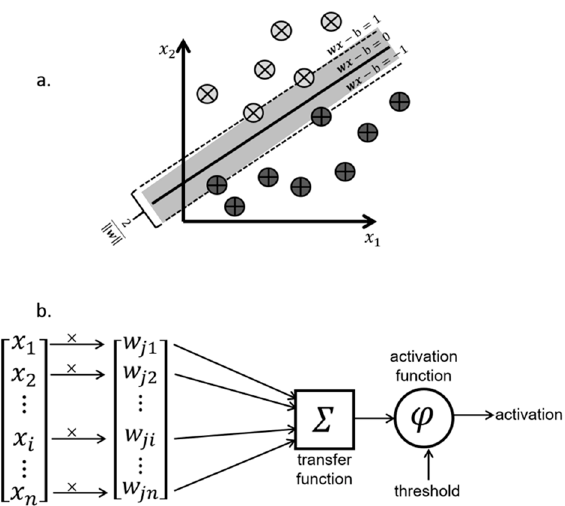
Figure 2. ( a ) A schematic diagram of the Support Vector Machine (SVM) classifier. The SVM model is a supervised machine learning algorithm that seeks a hyperplane that best separates two labeled classes from each other. The SVM maximizes the width of the gap between the two data clouds. In some cases, not all of the data points can be fitted into the two data clouds outside the shaded gap region. In the soft margin formulation of the SVM, points are allowed inside the gap but penalized in the cost function. ( b ) A schematic diagram of the Artificial Neural Network (ANN) model. The ANN is based on the feedforward multilayer perceptron architecture, consisting of an input layer, one or more sets of hidden layers, and one output layer. The ANN can be turned into a classifier by discretizing the network’s output. The basic substructure of the ANN is perceptron. For all but the input layer, the perceptron has an input (the outputs of the previous layer). The vectors of inputs and the neuron’s weights are multiplied by a dot product. Then, a transfer function is applied to the sum, giving an output for the next layer of perceptrons.